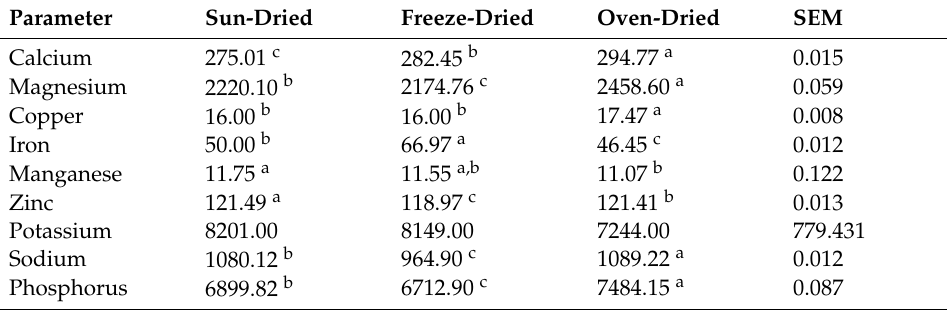
Table 3. Mineral composition (mg/kg) of dried mealworm larvae.